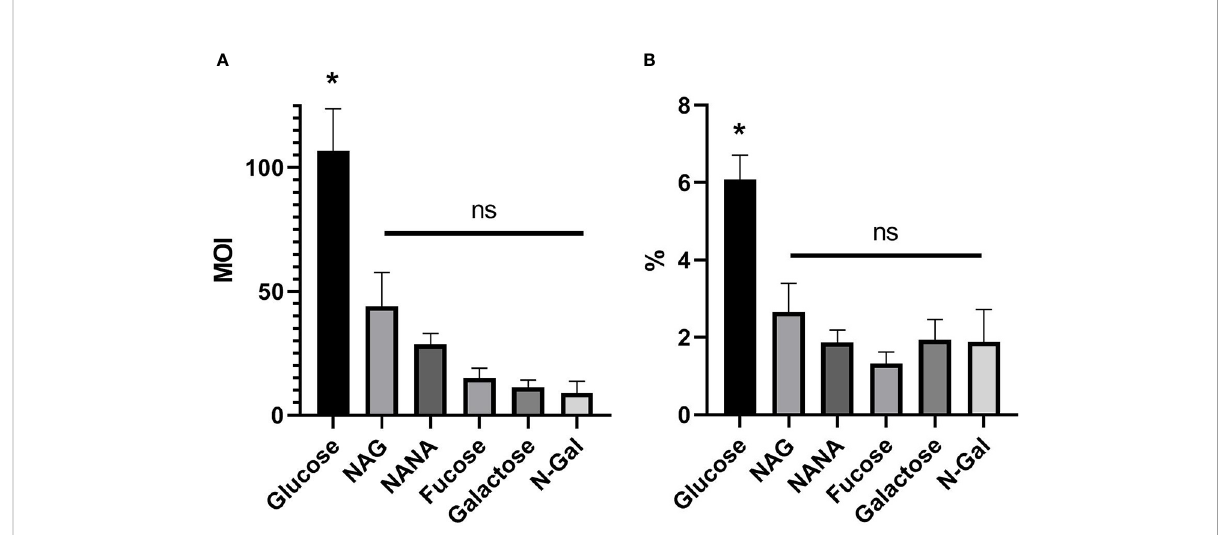
FIGURE 2 E. coli O157:H7 adhesion on HCT-8 cells in the presence of mucus-derived sugars. E. coli O157:H7 cultures were coincubated with HCT-8 monolayers in M9 medium + 10 mM mucus-derived metabolites (Fucose, Galactose, N-Gal. NANA or NAG) or Glucose at 37°C for 5 h at 37°C in a humidi fi ed 5% CO 2 incubator. (A) Multiplicity of infection (MOI) for each treatment, calculated as number of adhered bacteria/number of total HCT-8 cells. (B) Percentage of adherent bacteria, expressed as adherent bacteria/total bacteria. Data shown as mean ± SEM (*p < 0.05, n = 5).